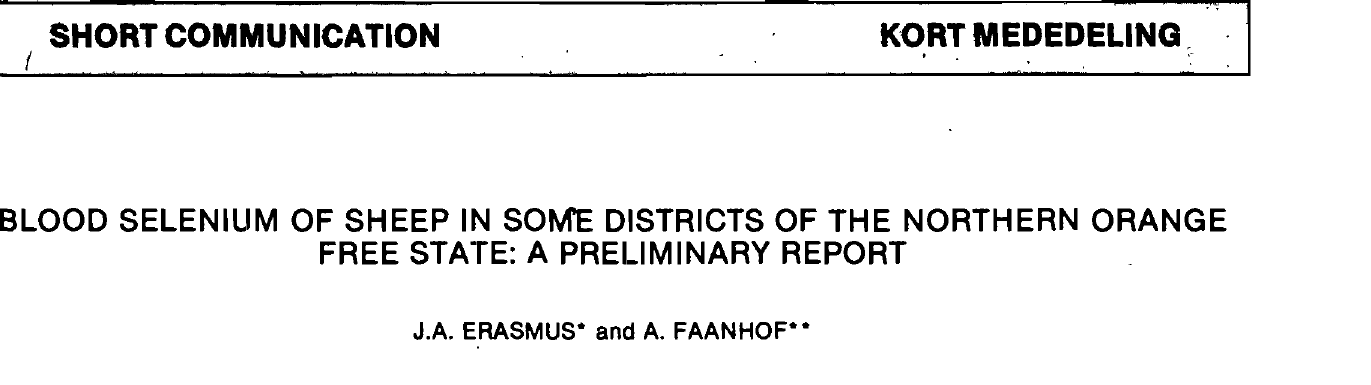
Table 1: RANGES FOR BLOOD SELENIUM FOR SHEEP IN THE BETHLEHEM- FOURIESBURG, KROONSTAD AND BULTFONTEIN DISTRICTS (,ug/ml) Figure shown District by median